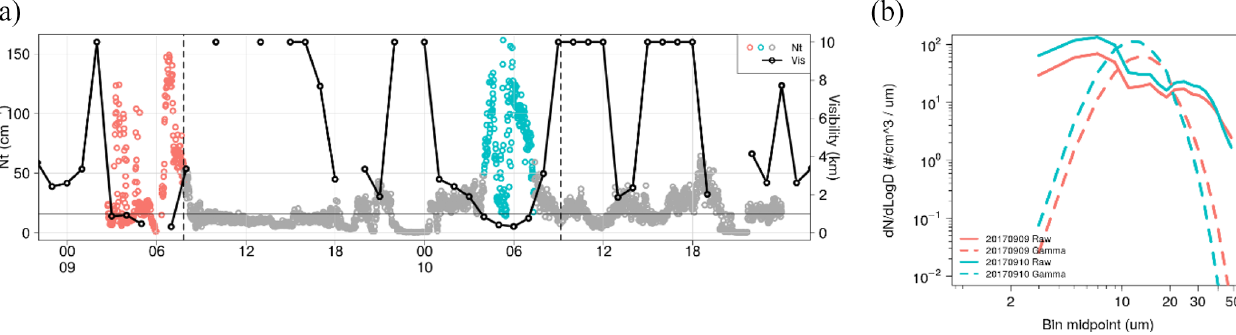
Figure 18. (a) Time series of cloud droplet count ( N t ) and visibility. Vertical dashed lines represent sonde release times. The grey horizontal line at 1km visibility represents fog conditions. Time is in UTC (site is UTC + 2). (b) Droplet size distribution for the two case studies when visibility was 1km or less is shown. Colours match with the colours in the time series. Solid lines are the observed distributions. Dashed lines are the equivalent theoretical gamma distribution applied to the observed